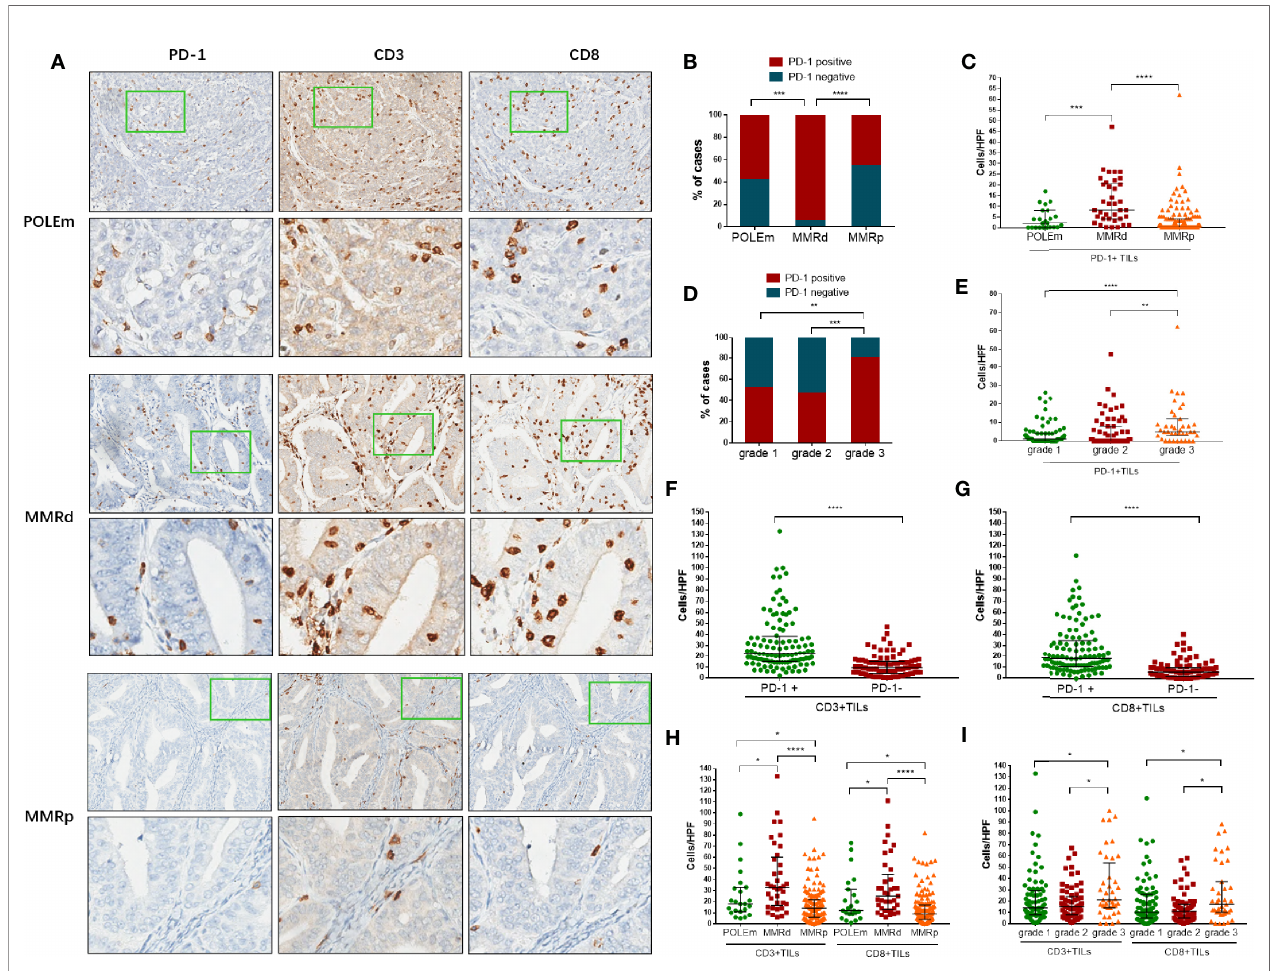
FIGURE 3 | Analysis of PD-1+ TILs, CD3+ TILs and CD8+ TILs in endometrial cancer. (A) Representative images of POLEm, MMRd and MMRp tumors. (B) Proportion of cases positive/negative for PD-1 in POLEm, MMRd and MMRp tumors. (C) Comparison of PD-1+ TILs from POLEm, MMRd and MMRp tumors. (D) Proportion of cases positive/negative for PD-1 in grade-1, grade-2 and grade-3 tumors. (E) Comparison of PD-1+ TILs from grade-1, grade-2 and grade-3 tumors. (F) Comparison of CD3+TILs between PD-1+ and PD-1 − tumors. (G) Comparison of CD8+TILs between PD-1+ and PD-1 − tumors. (H) Comparison of CD3+ and CD8+TILs from POLEm, MMRd and MMRp tumors. (I) Comparison of CD3+ and CD8+TILs from grade-1, grade-2 and grade-3 tumors. POLEm, POLE mutation; MMRd, MMR de fi ciency; MMRp, MMR pro fi ciency. TIL, tumor in fi ltrating lymphocyte. Chi-square test, Fisher ’ s exact test, Kruskal – Wallis test, and Mann – Whitney test were used, with p <0.05 indicating statistical signi fi cance. *P <0.05; **P <0.01; ***P <0.001; ****P